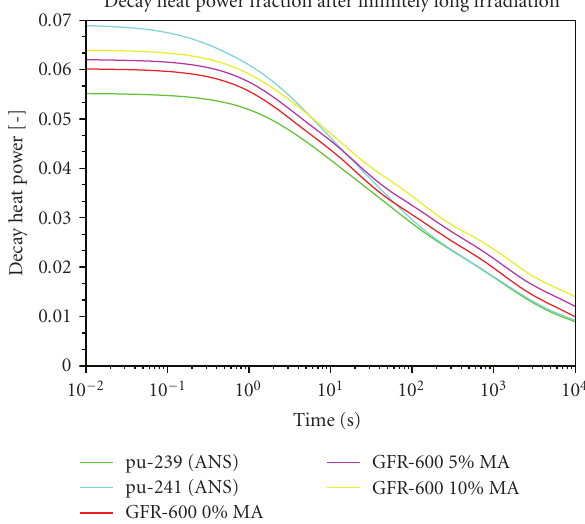
Figure 10: Decay power after an infinitely long irradiation period for the two plutonium isotopes present in the ANS5.1 standard and for the 3 GFR-600 mixtures (cf.